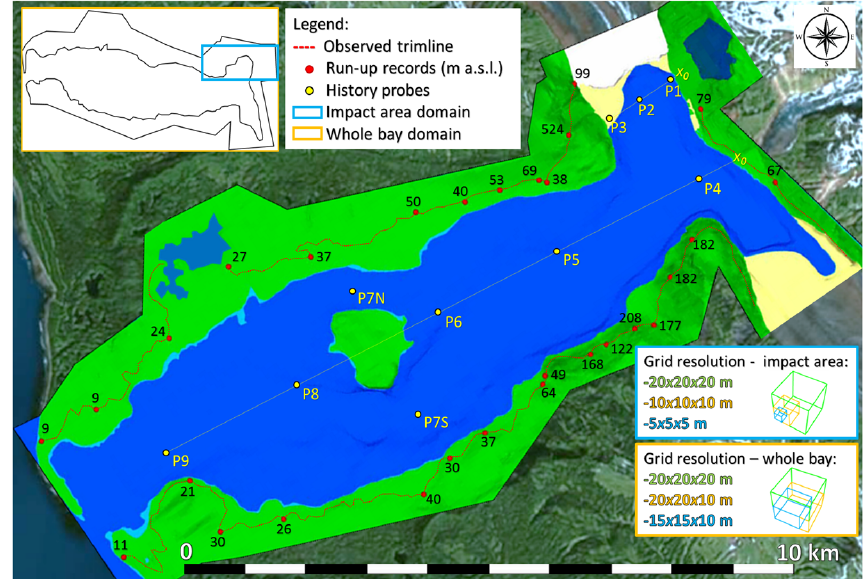
Figure 5. Model setup, covering the impact area (light blue rectangle) and the whole bay (orange rectangle); the different adopted grid resolutions are shown. Observation gauges (history probes, shown as yellow points) represent water level gauges; x 0 at the impact point and at the shoreline of Cascade glacier represents the origin for the longitudinal distance of the gauges. The observed trimline (dotted red lines) and the documented run-up values along the bay (red spots) are used for model validation (background topography from © Google Earth Pro 7.3.2.5776; last access: 24 April